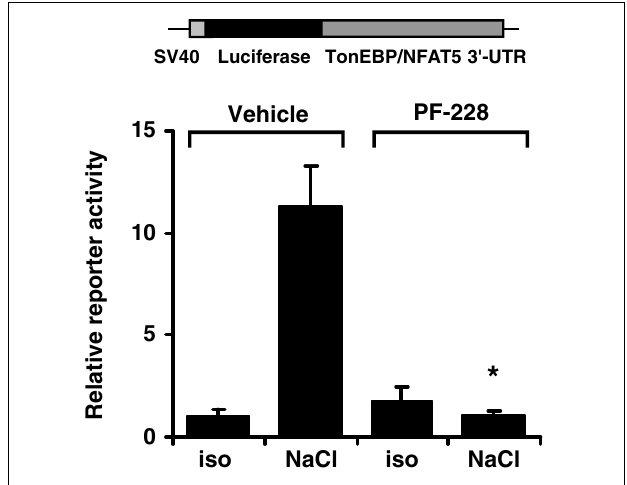
FIGURE 10 | Effect of FAK inhibition on TonEBP/NFAT5 3 (cid:2) -UTR activity. HEK293 cells were transfected with a reporter construct containing the full-length TonEBP/NFAT5 3 (cid:2) -UTR distal to the luciferase ORF. Subsequently, the cells were incubated for 24h in isotonic (300mosm/kg H 2 O) or hypertonic medium (450mosm/kg H 2 O by NaCl addition) of 10 μ M PF-228 or only vehicle ethanol. Thereafter, reporter activity was determined as described in Methods. Means ± s.e.m. for n = 4 ∗ p < 0 . 05 vs. NaCl +